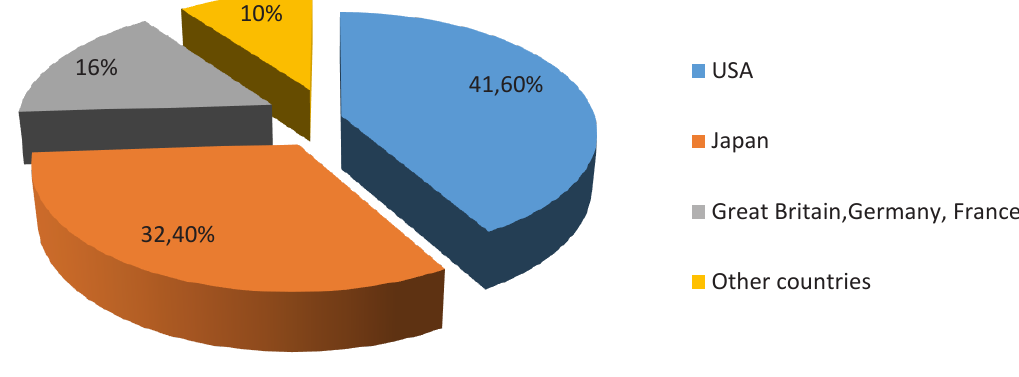
Figure 1. Structure of the world advertising market in 2017